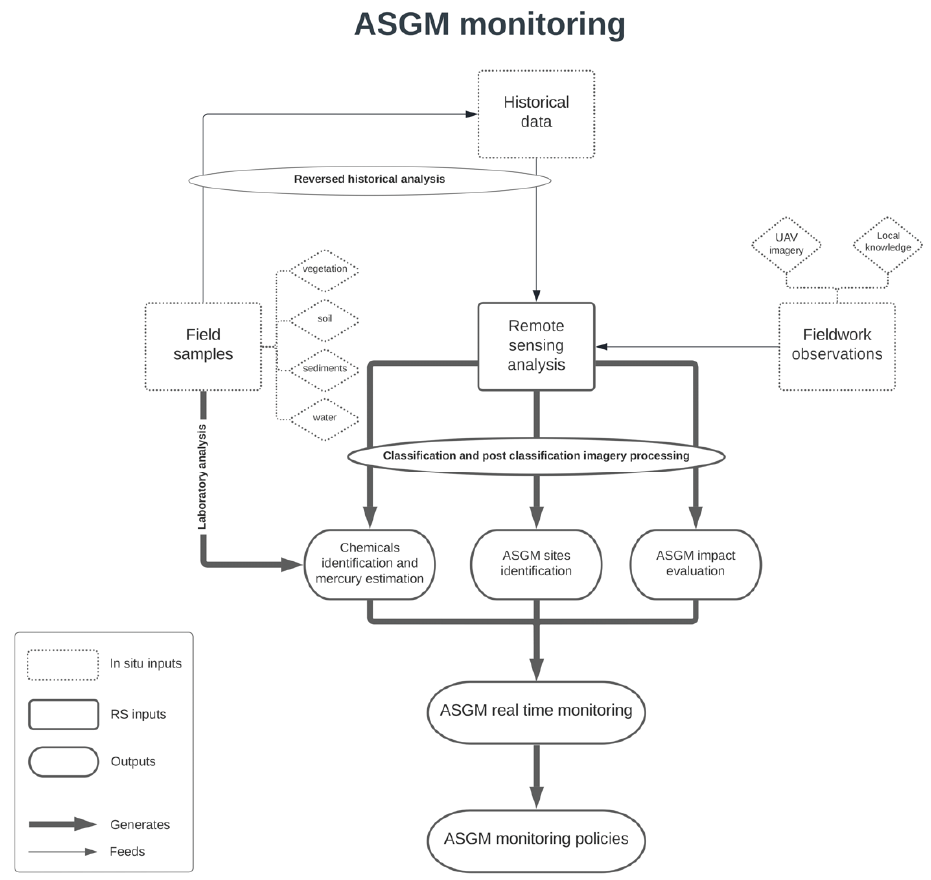
Figure 4. Proposed methodology for ASGM monitoring .